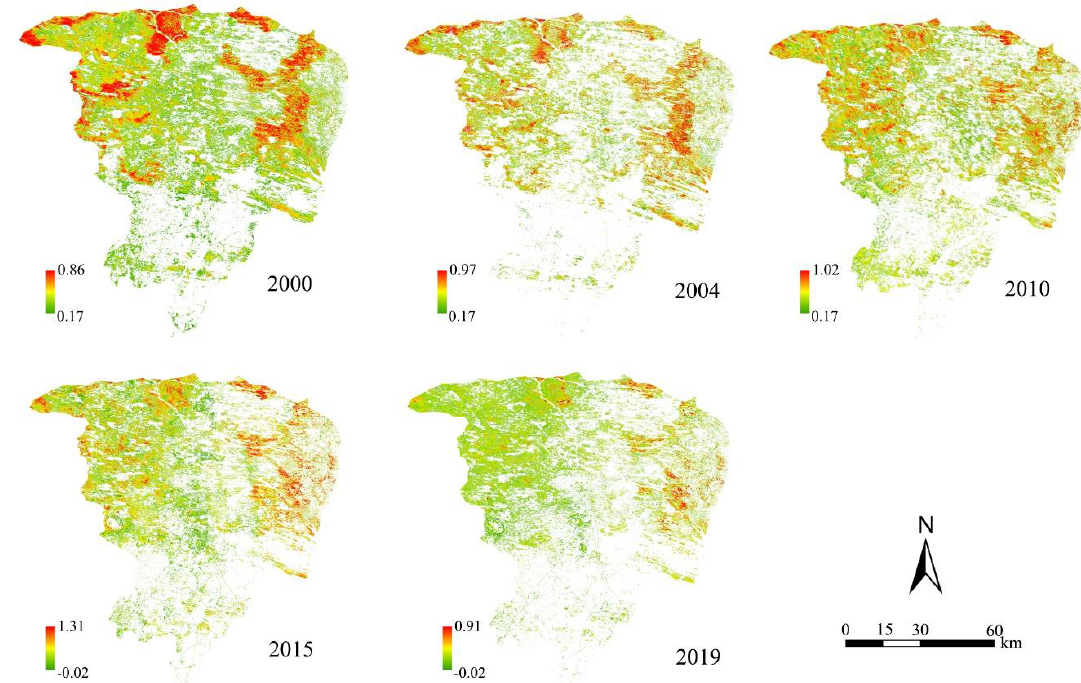
Figure 9. Calculation results of the DI. The DI comprehensively reflects the status of aeolian desertification in the Zhenglan Banner. A larger DI represents a higher degree of aeolian desertification.